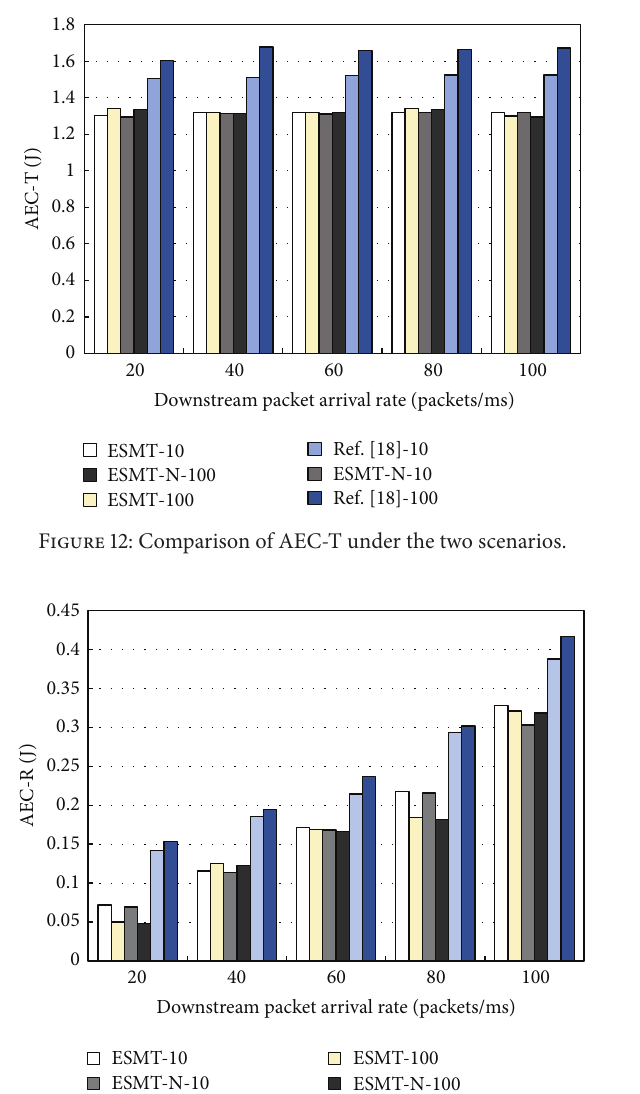
Figure 13: Comparison of AEC-R under the two scenarios.